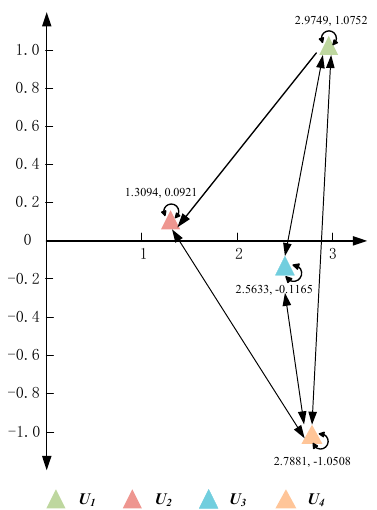
Figure 1. The correlation between the primary indicators.